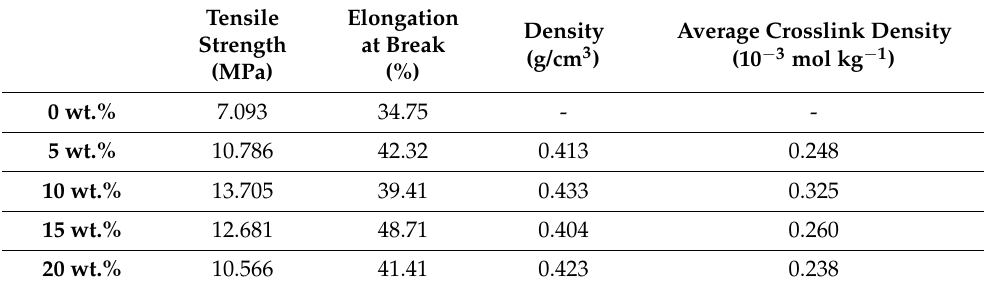
Table 3. Mechanical properties used to calculate the average crosslink